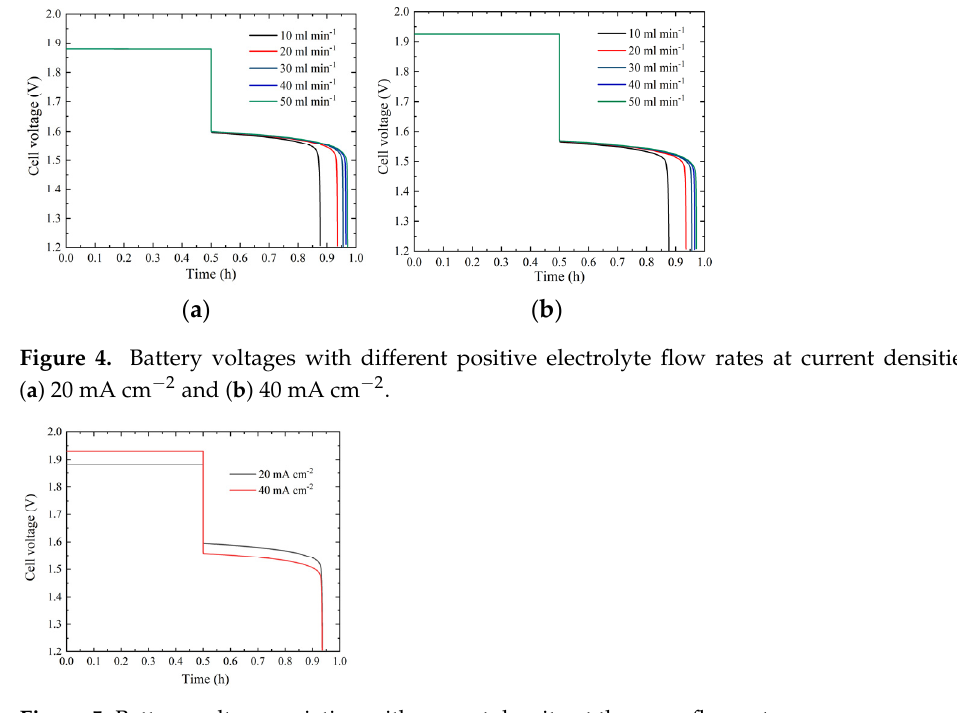
8 of 20 Figure 3. Simulated voltage of ZBFB at a current density of 20 mA cm (cid:2879)(cid:2870) compared with the exper- imental voltage. 3. Results and Discussion 3.1. E ff ect of Electrolyte Flow Rate The experiment has shown that increasing the positive electrolyte fl ow rate of ZBFB improves electrolyte transport and bromine redox reaction kinetics [35]. Figure 4 shows ba tt ery voltages with di ff erent positive electrolyte fl ow rates at current densities of 20 and 40 mA cm (cid:2879)(cid:2870) to further reveal how the bromine redox reaction is a ff ected. As shown in Figure 5, the ba tt ery overpotential increases with current density at the same fl ow rate. Because more active species are needed for reaction, insu ffi cient electrolytes may increase concentration polarization. With increasing electrolyte fl ow rate, ba tt ery discharge capac- ity increases signi fi cantly at the same current density. As shown in Table 4, at 20 mA cm (cid:2879)(cid:2870) , increasing the electrolyte fl ow rate from 10 to 50 ml min (cid:2879)(cid:2869) increases the discharge ca- pacity by 0.58 Ah. The performance is even preferable at 40 mA cm (cid:2879)(cid:2870) when the electrolyte